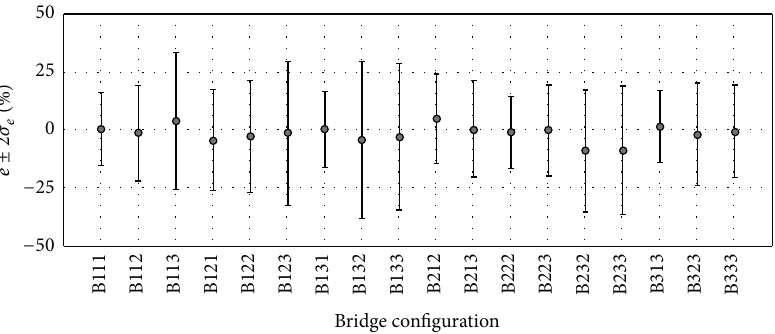
Figure 5: Mean and 95% confidence range for deck displacements.